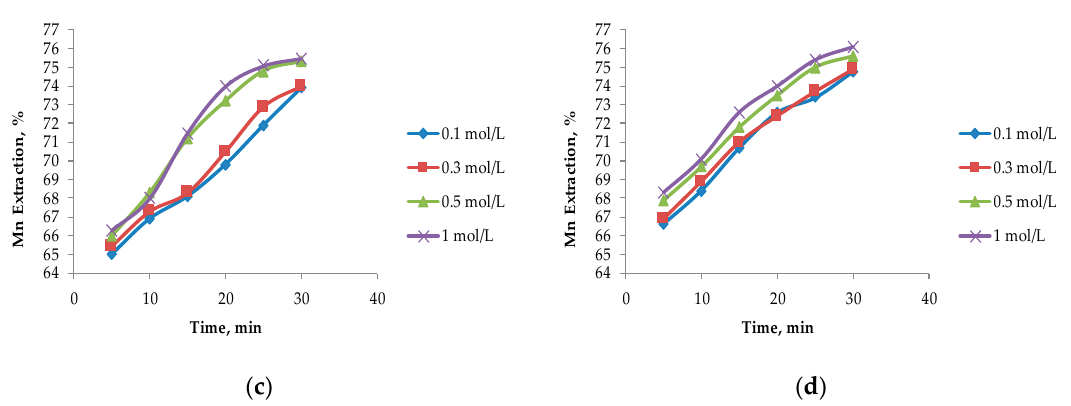
Figure 4. Effect on the acid concentration at different ratios of MnO 2 /Fe 2 O 3 : ( a ) Ratio 2:1; ( b ) ratio 1:1; ( c ) ratio 1:2; and ( d ) ratio 1:3 (25 °C, 600 rpm, − 75 + 53 μ m).